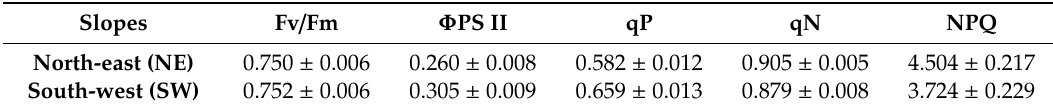
Table 1. Chlorophyll a fluorescence parameter (Fv / Fm (ratio of variable to maximum fluorescence), photochemical quantum yield of photosystem II ( Φ PS II), photochemical fluorescence quenching (qP), fluorescence quenching (qN), and non-photochemical quenching (NPQ) for S. ruralis after three days of recovery (fully hydrated state) at two di ff erent expositions of the dune (NE: north-east slope, SW: south-west slope).